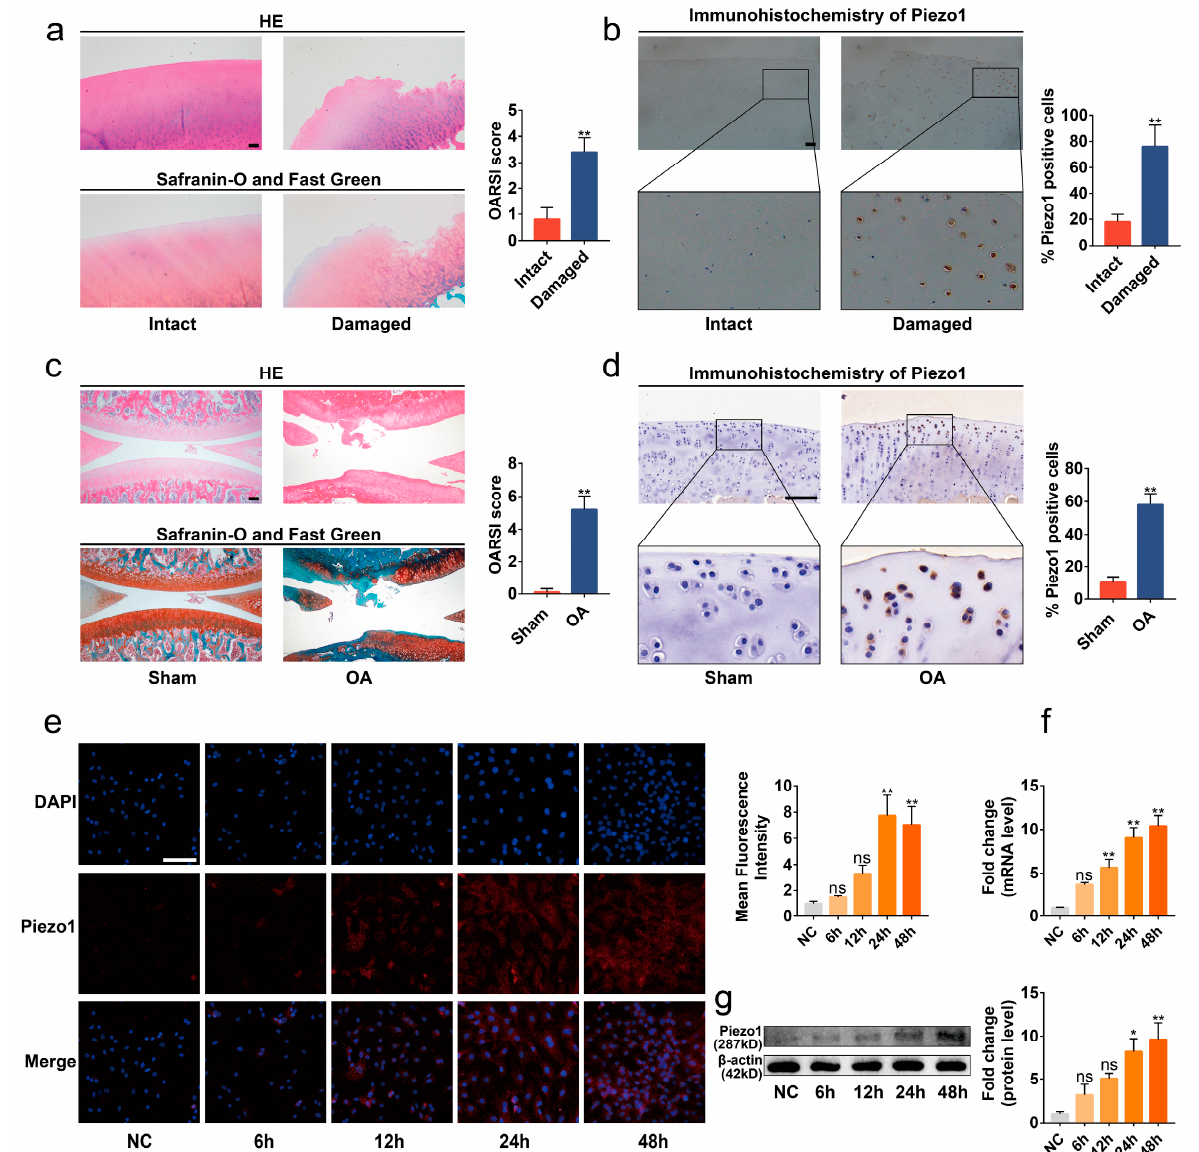
Figure 1. Piezo1 was up-regulated in the articular cartilage of OA patients and rats. ( a , c ) Representative images of HE, Safranin-O/Fast Green staining of intact and damaged areas in OA patients’ articular, Sham, and OA rat cartilage, and OARSI scores ( n = 5). ( b , d ) Immunohistochemistry staining of intact and damaged areas in OA patients’ articular, Sham, and OA rat cartilage, and the percentage of Piezo1 positive cells ( n = 5). ( e ) Immunofluorescence staining and quantified results of Piezo1 in chondrocytes exposed to mechanical strain for 0 h, 6 h, 12 h, 24 h, and 48 h ( n = 3). ( f , g ) RT-qPCR and Western blot analysis of Piezo1 in chondrocytes exposed to mechanical strain for 0 h, 6 h, 12 h, 24 h, and 48 h. * p < 0.05; ** p < 0.01; ns, no significant differences. Mann–Whitney U test for ( a , c ), Student’s t-test for ( b , d ), one-way ANOVA with Bonferroni’s test for ( e – g ); scale bar: 100 μ m.